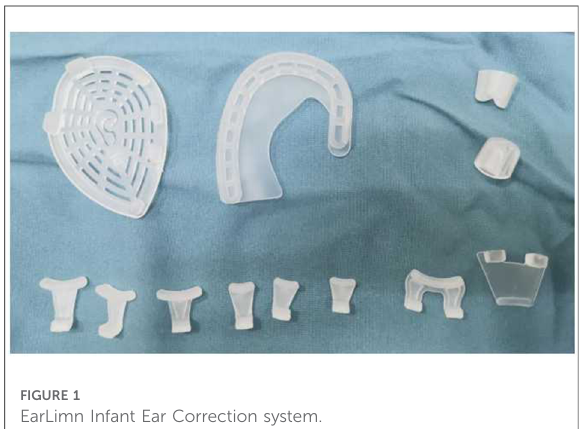
FIGURE 1 EarLimn Infant Ear Correction